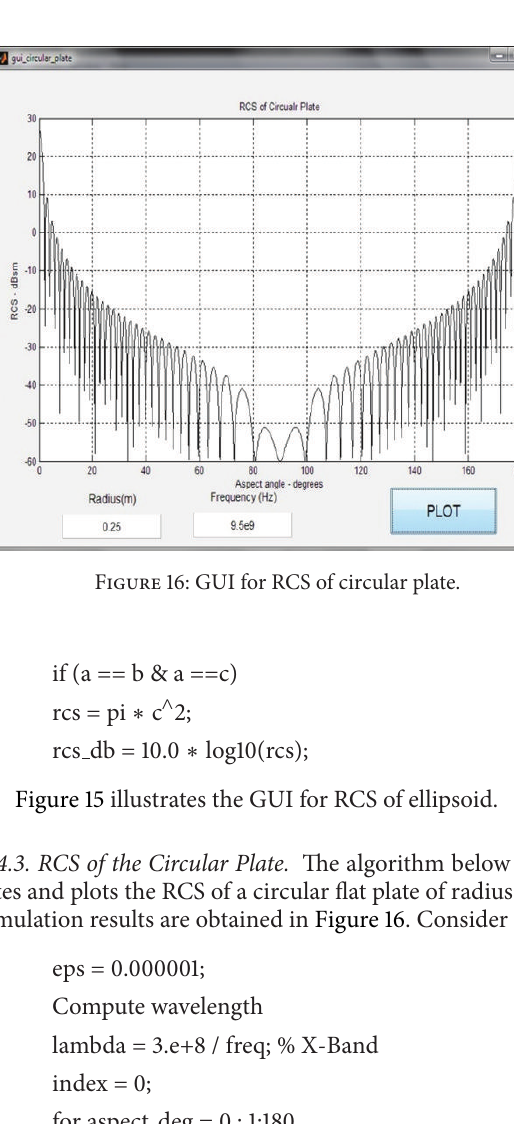
Figure 15: Graphical User Interface for RCS of ellipsoid.